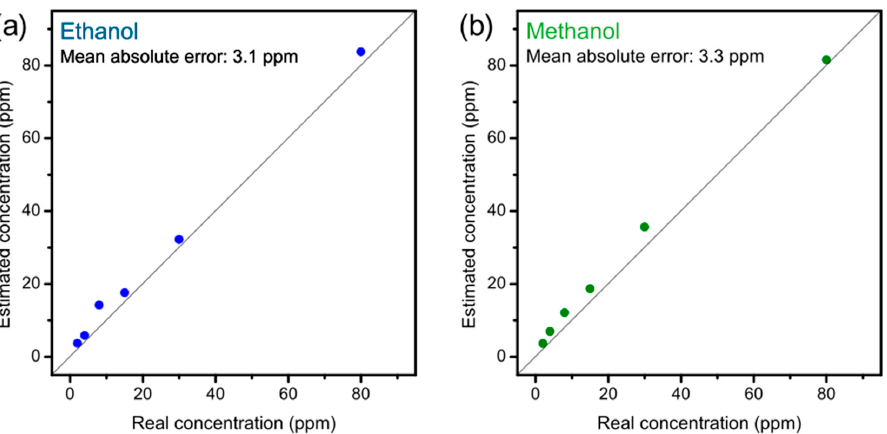
Figure 4. Estimation of the concentration of ( a ) ethanol and ( b ) methanol, obtained with a linear regression by means of a support vector machine.